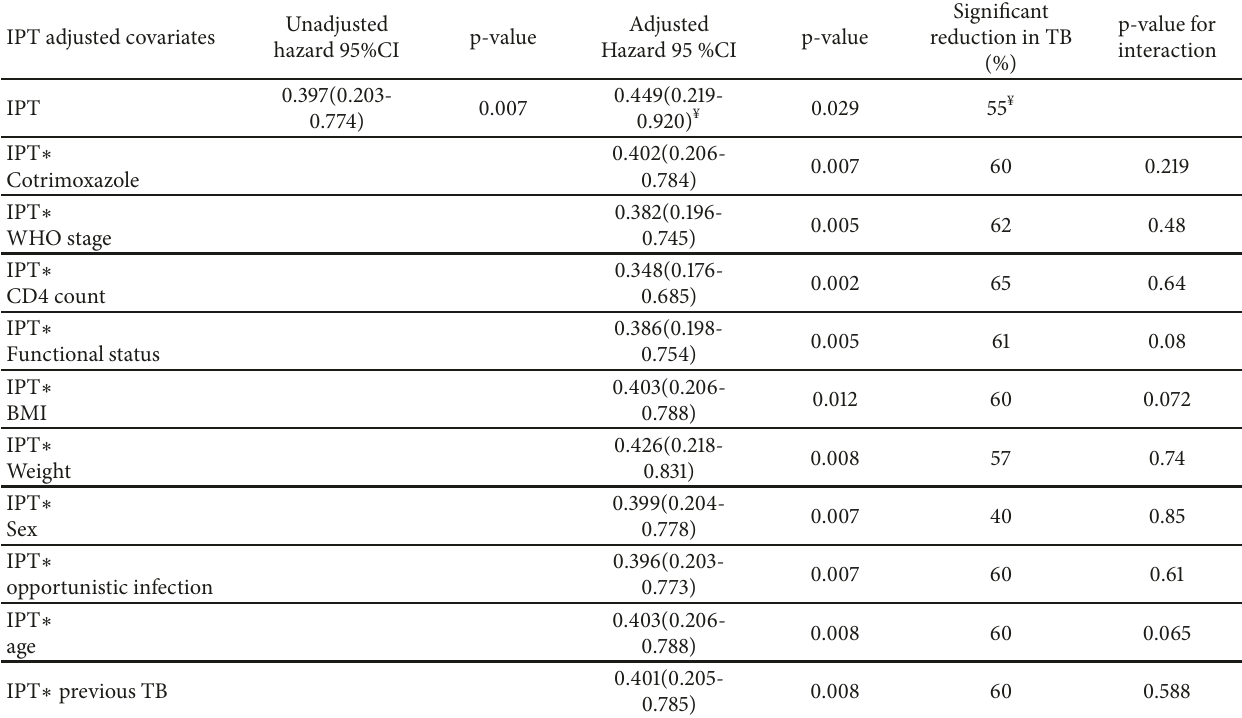
Table 5: Effect of IPT on reduction of tuberculosis incidence among cohorts of PLWHA at Nekemte referral hospital and Nekemte Health center followed from September 2009-September